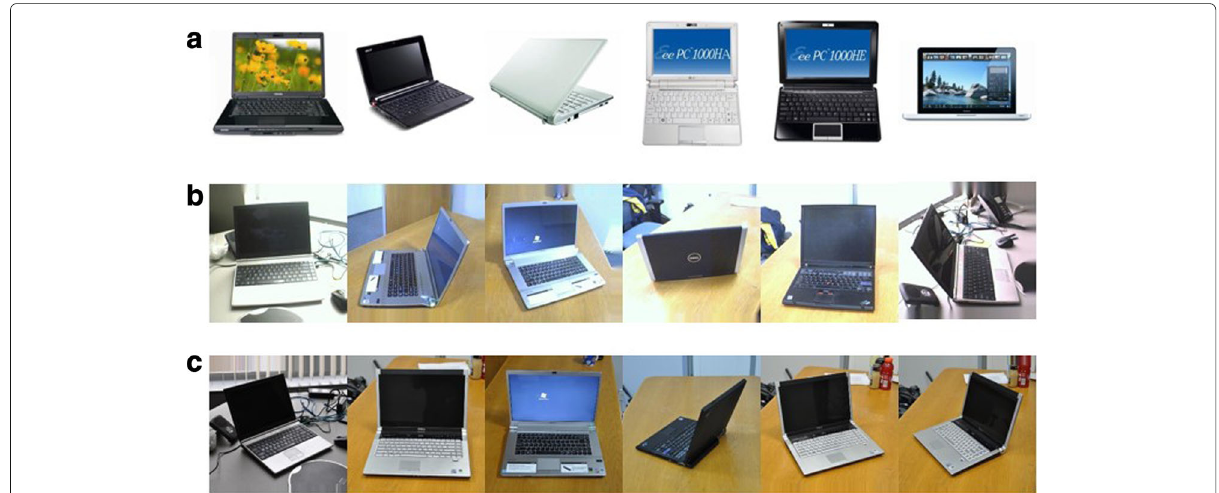
Fig. 3 Example images from the “laptop_computer” class in a Amazon, b Webcam, and c DSLR